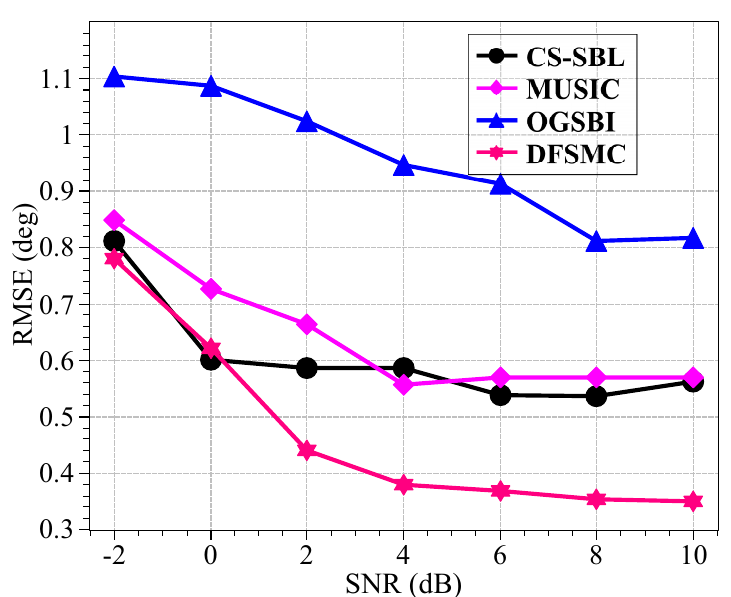
Figure 9. The direction estimation performance with different